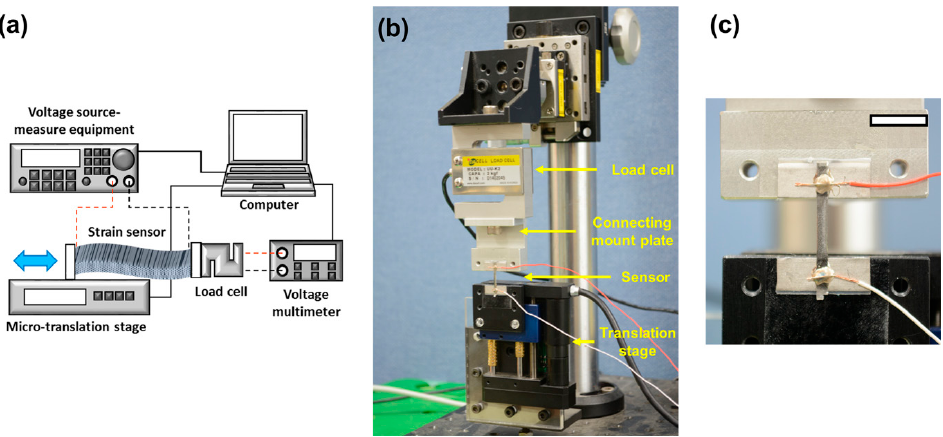
Figure 1. ( a ) Schematic diagram of the experimental setup, ( b ) photograph of experimental setup for measuring variation of stress and resistance under applied strain, ( c ) close up photograph of the stretchable strain sensor attached on the experimental system.